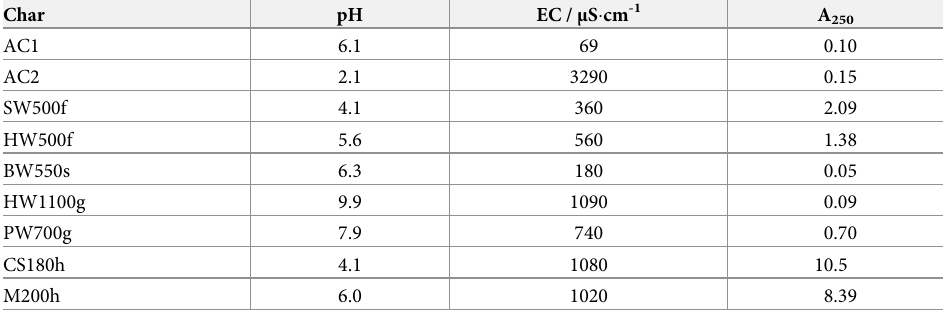
Table 5. Value of pH, electrical conductivity (EC) and UV absorbance determined at 250nm for the different